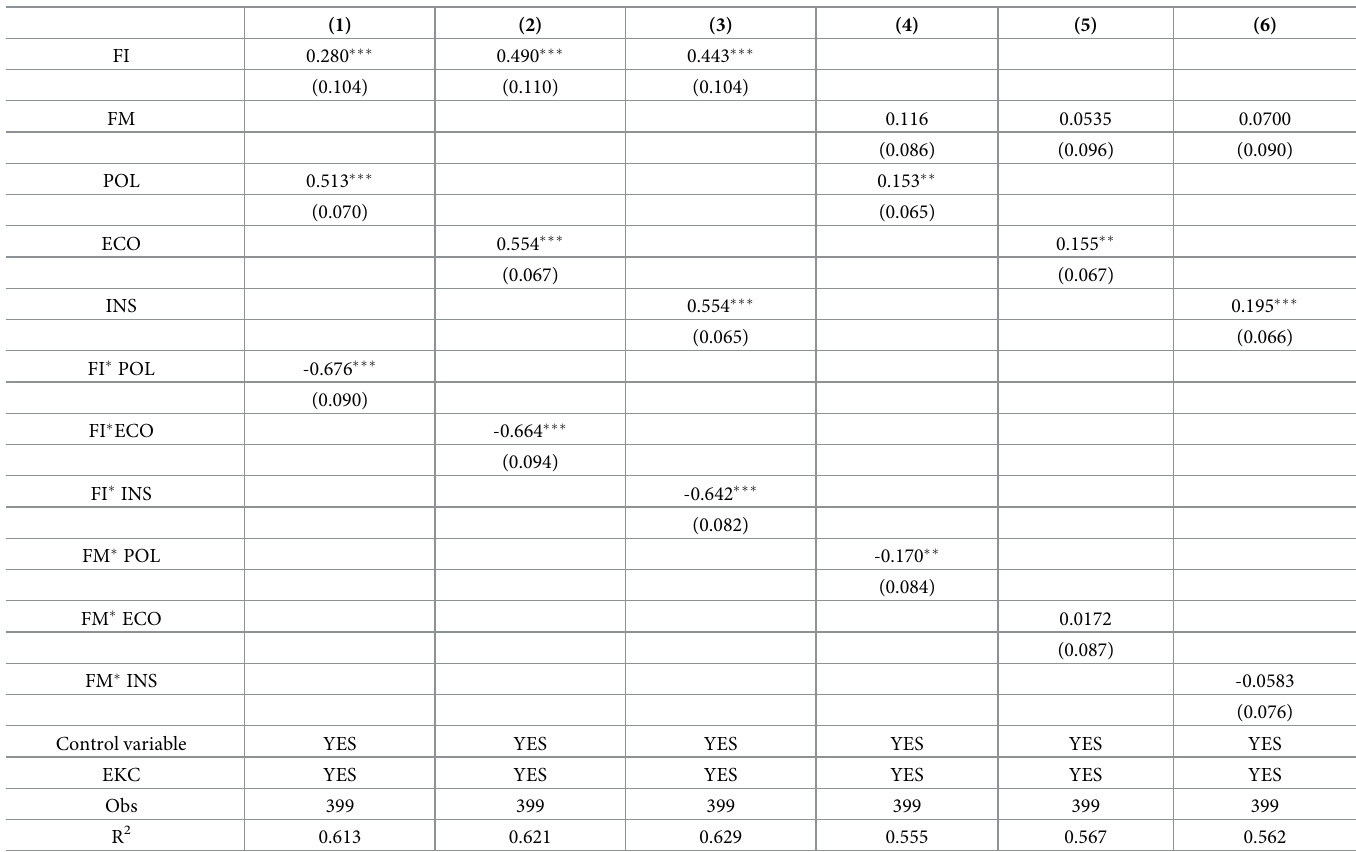
Table 6. Results of governance quality sub-indicator